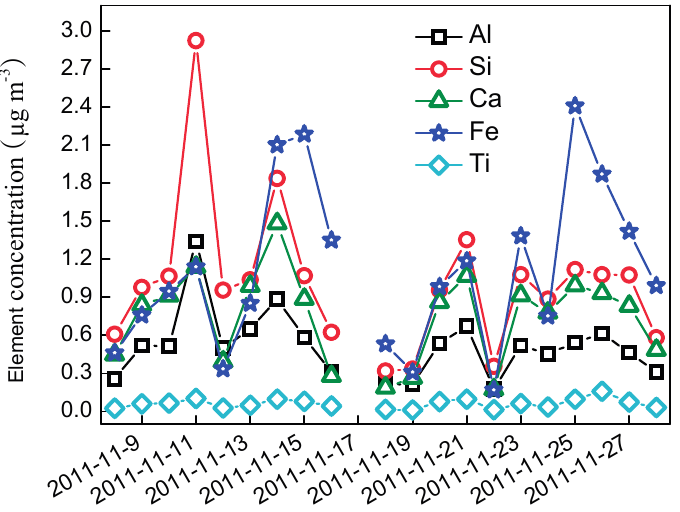
Figure 6. Time series of crustal elements concentration.